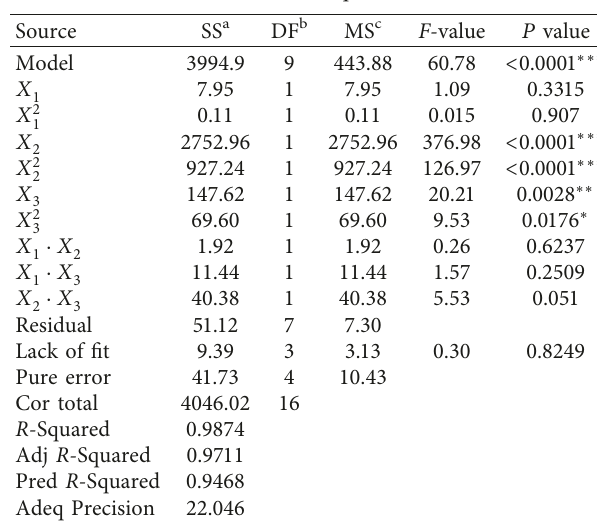
Table 3: ANOVA for quadratic